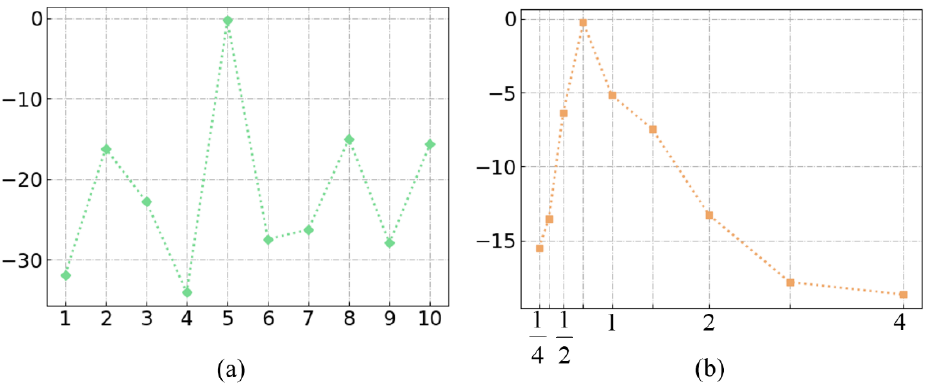
Figure 9. Slice figures of SA Net: ( a ) Class dimension and ( b ) Scale dimension.